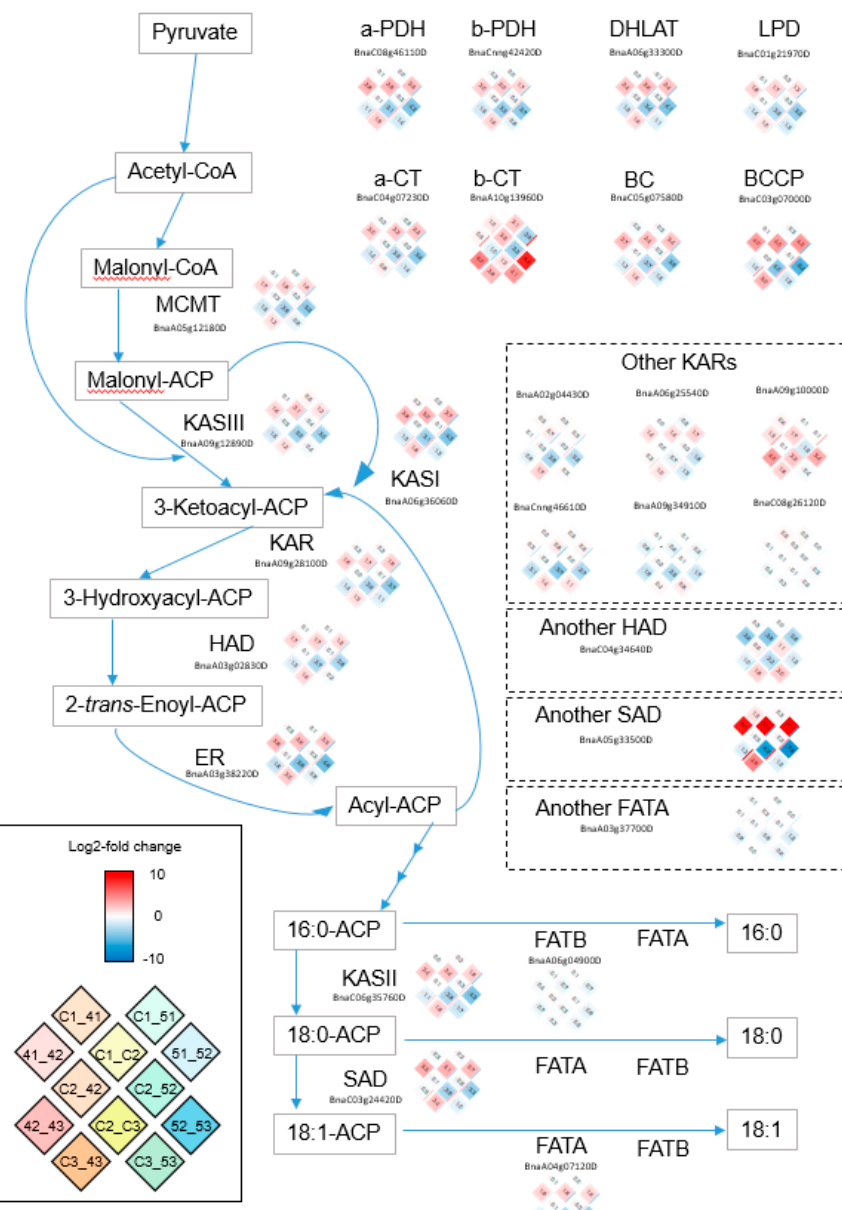
Figure 5. B. napus genes involved in the plastidial fatty acid synthesis and their log2-fold expression changes. As representatives of genes involved in the same biochemical step, log2-fold changes of the most highly expressed genes are shown: the expression patterns were similar among them, except those stated separately and shown in the dotted boxes. Solid box: heatmap scale of log2-fold gene expression change and positions of log2-fold change for 12 pair-wise comparisons. α -PDH: pyruvate dehydrogenase alpha subunit; α -CT: carboxyltransferase alpha subunit of heteromeric ACCase; β -CT: carboxyltransferase beta subunit of heteromeric ACCase; β -PDH: pyruvate dehydrogenase beta subunit; BC: biotin carboxylase, a subunit of heteromeric ACCase; BCCP: biotin carboxyl carrier protein, a subunit of heteromeric ACCase; DHLAT: dihydrolipoamide acetyltransferase; ER: enoyl-ACP reductase; FAT: acyl-ACP thioesterase; HAD: hydroxy acyl-ACP dehydrase; KAR: ketoacyl-ACP reductase; KAS: ketoacyl-ACP synthase; LPD: dihydrolipoamide dehydrogenase; MCMT: malonyl-CoA:ACP malonyltransferase; SAD: stearoyl-ACP desaturase.